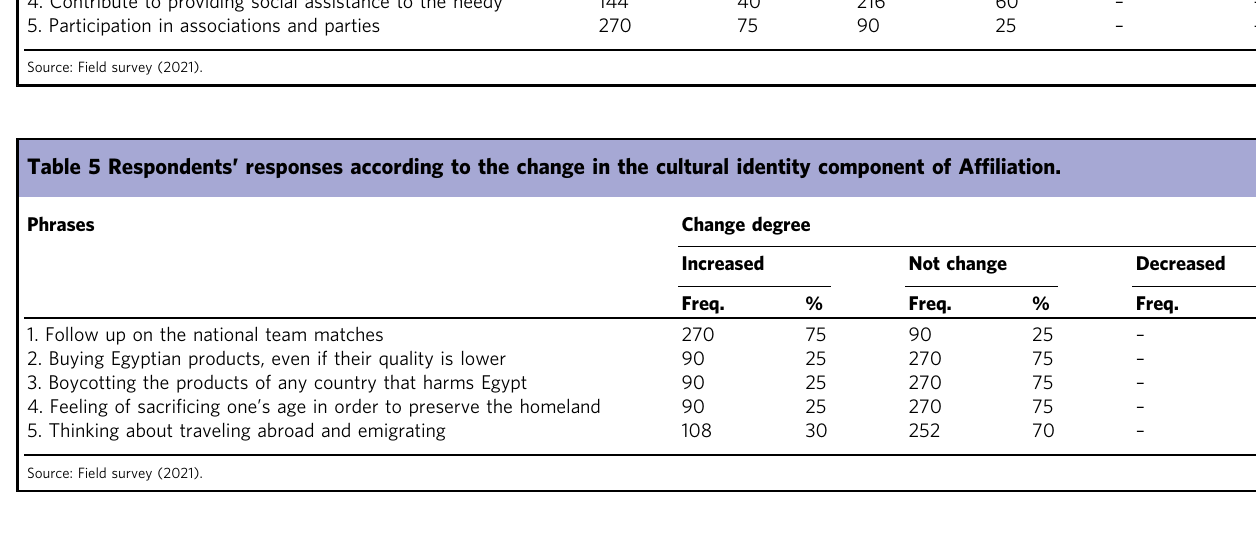
Table 6 Respondents ’ responses according to the change in the cultural identity component of time